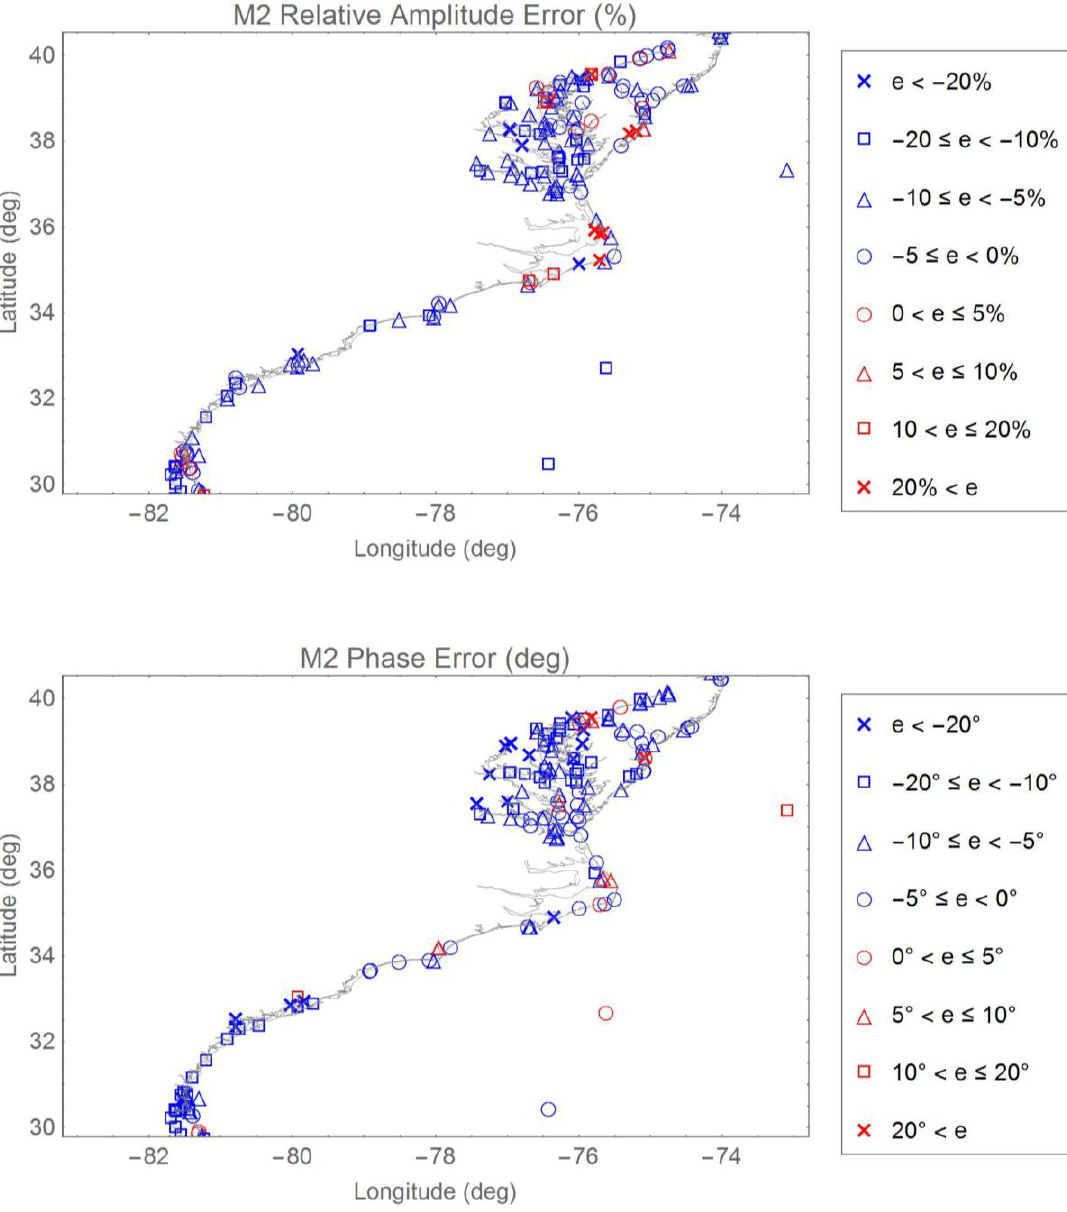
Figure C6. Distribution of relative amplitude and absolute phase errors for the M 2 constituent: Atlantic coast from Delaware to Georgia.